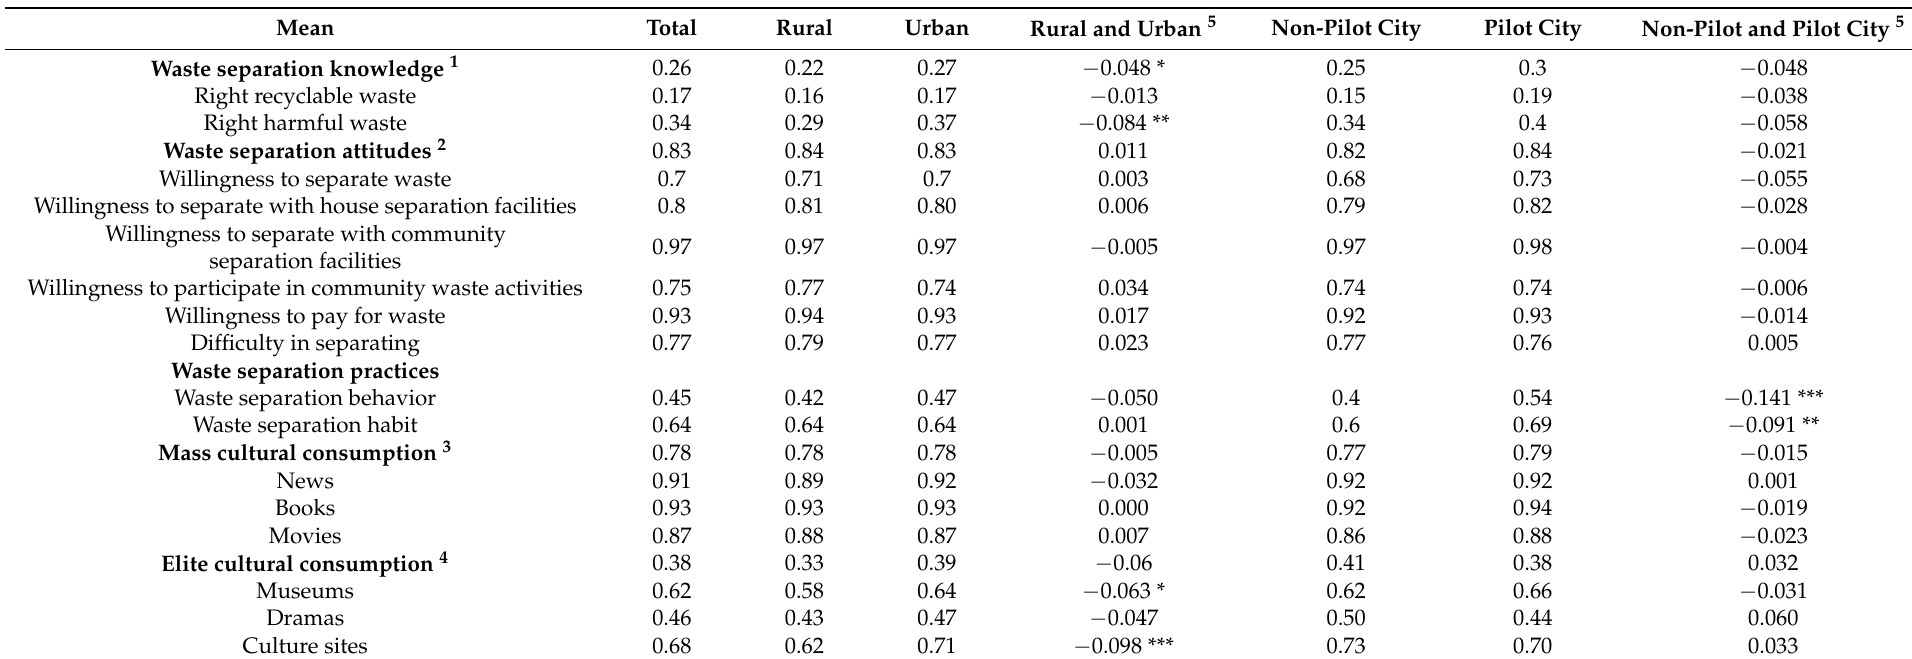
Table 2. Knowledge, attitudes, and practices of waste separation and cultural consumption across different regions in China. Mean Total Rural